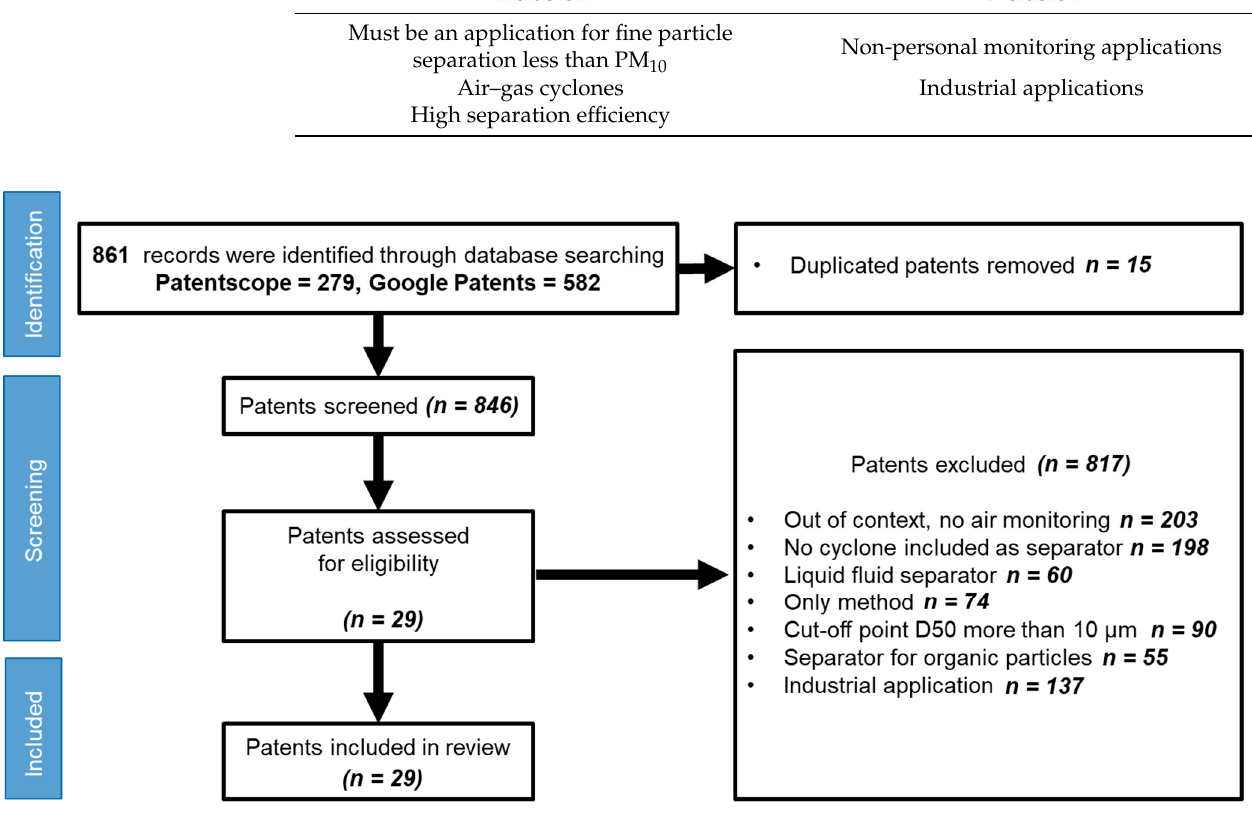
Figure 2. Flow chart of the search methodology in databases.